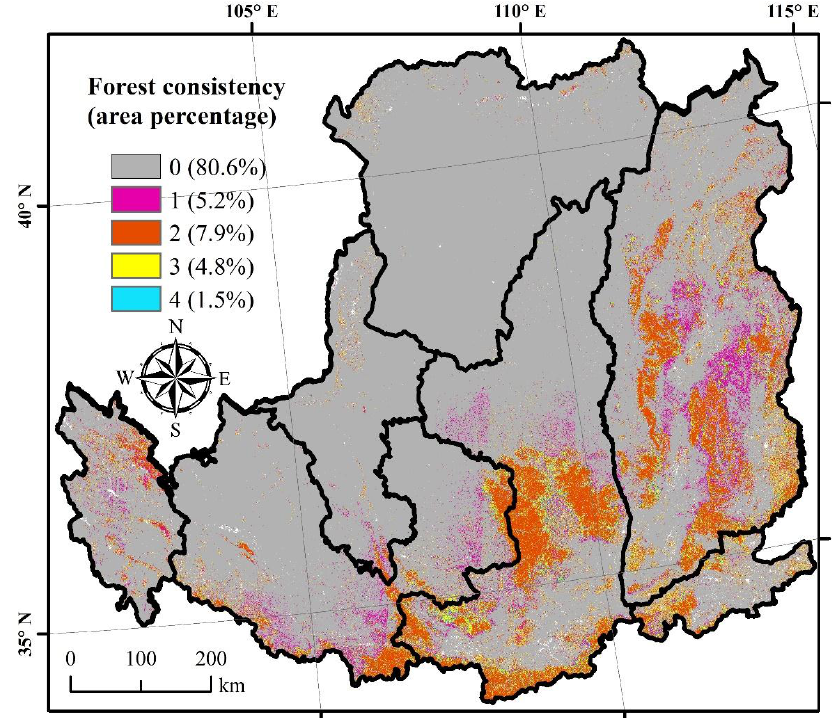
Figure 7. The spatial distribution map of the forest frequency in the Loess Plateau in 2010. The input forest maps were from the PALSAR/Landsat forest map, JAXA forest map, FROM-GLC forest map, and OU-FDL forest map, respectively.